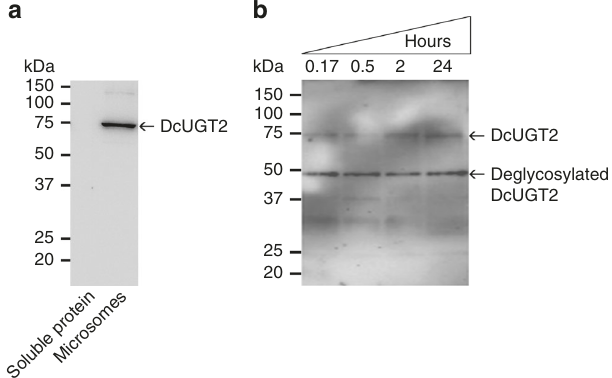
Fig. 8 The DcUGT2 from Dactylopius coccus is a glycoprotein. D. coccus proteins were either non-treated or deglycosylated with glycanases for different periods of time. Protein samples were separated on an SDS gel followed by western blotting using an anti-DcUGT2 antibody. a Non- treated D. coccus soluble protein and microsomes. b D. coccus microsomes treated with glycanases for 10 min (0.17), 30 min (0.5), 2 h (2), and 24